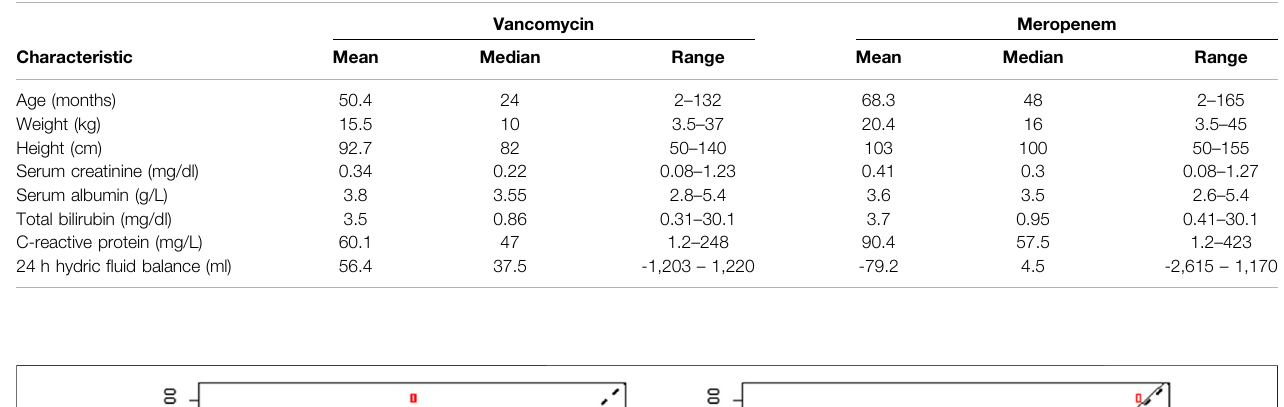
Frontiers in Pharmacology |